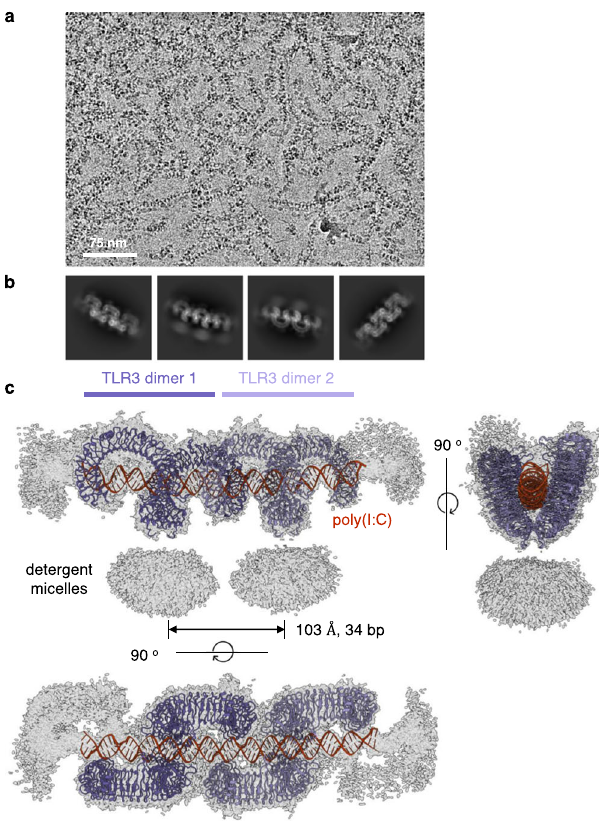
Fig. 1 | Cryo-EM structure of full-length TLR3 in complex with poly(I:C) RNA. a Representative micrographic image of the TLR3-poly(I:C) complex. TLR3 forms regularly spaced and linear clusters along the poly(I:C) RNA strands. b Representative2DclassaverageoftheTLR3-poly(I:C)complex. c Electrondensity map of the TLR3-poly(I:C) complex. Atomic models of two neighboring TLR3 dimers are superimposed. The transmembrane and intracellular domains are not visible in the map, presumably due to structure fl exibility at the juxtamembrane regions. A representative micrograph from an n =9527 cryo-EM experiment set is